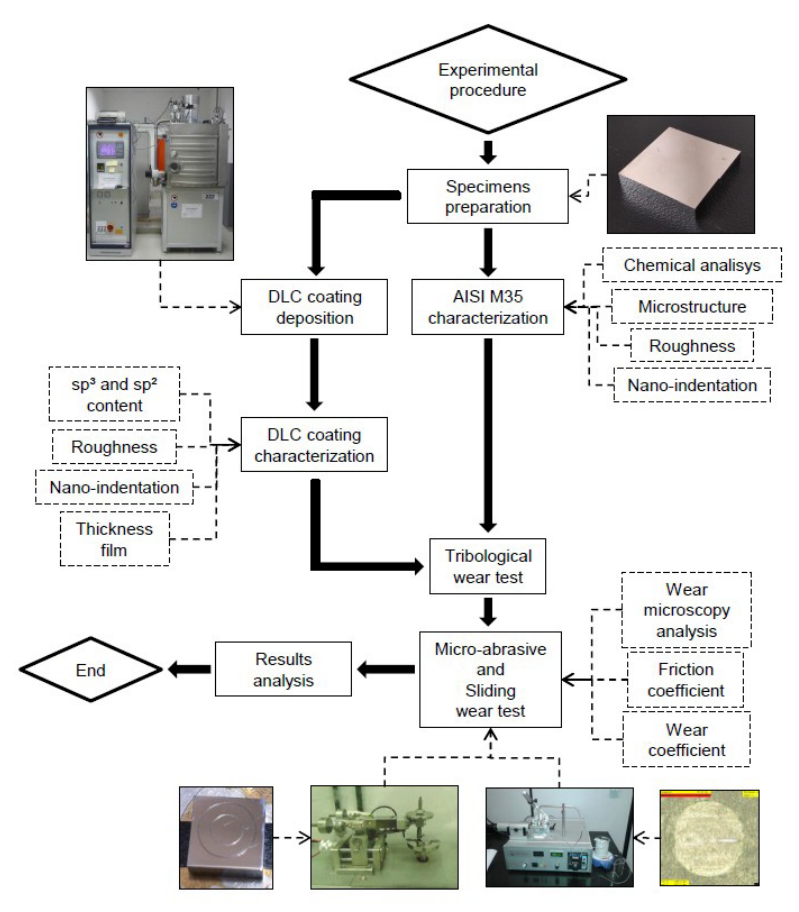
Figure 1. Methodological fluxogram followed on this study.